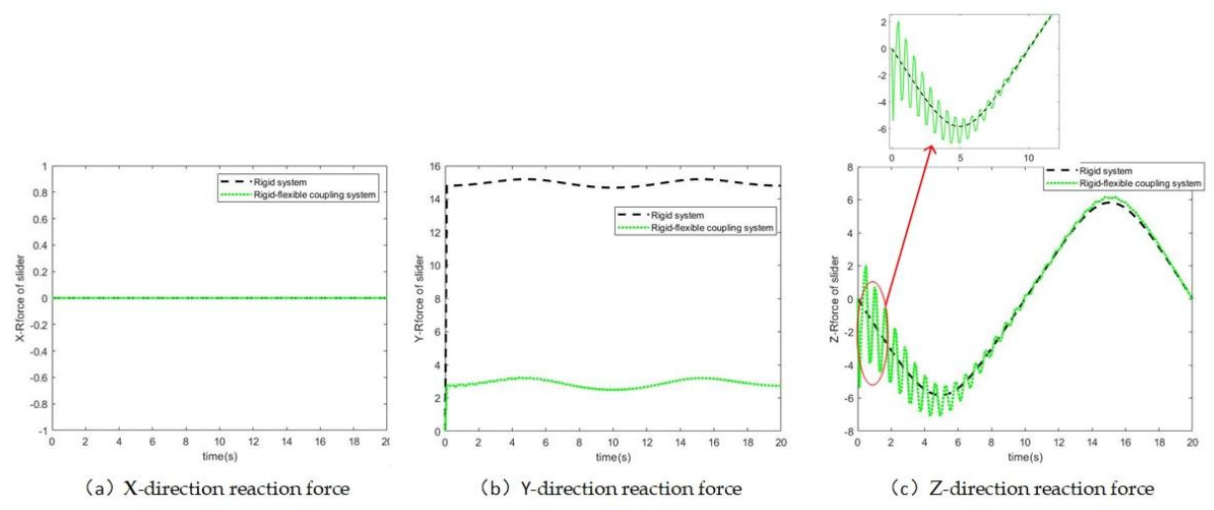
Figure 10. Reaction force of rotation joint of slider.